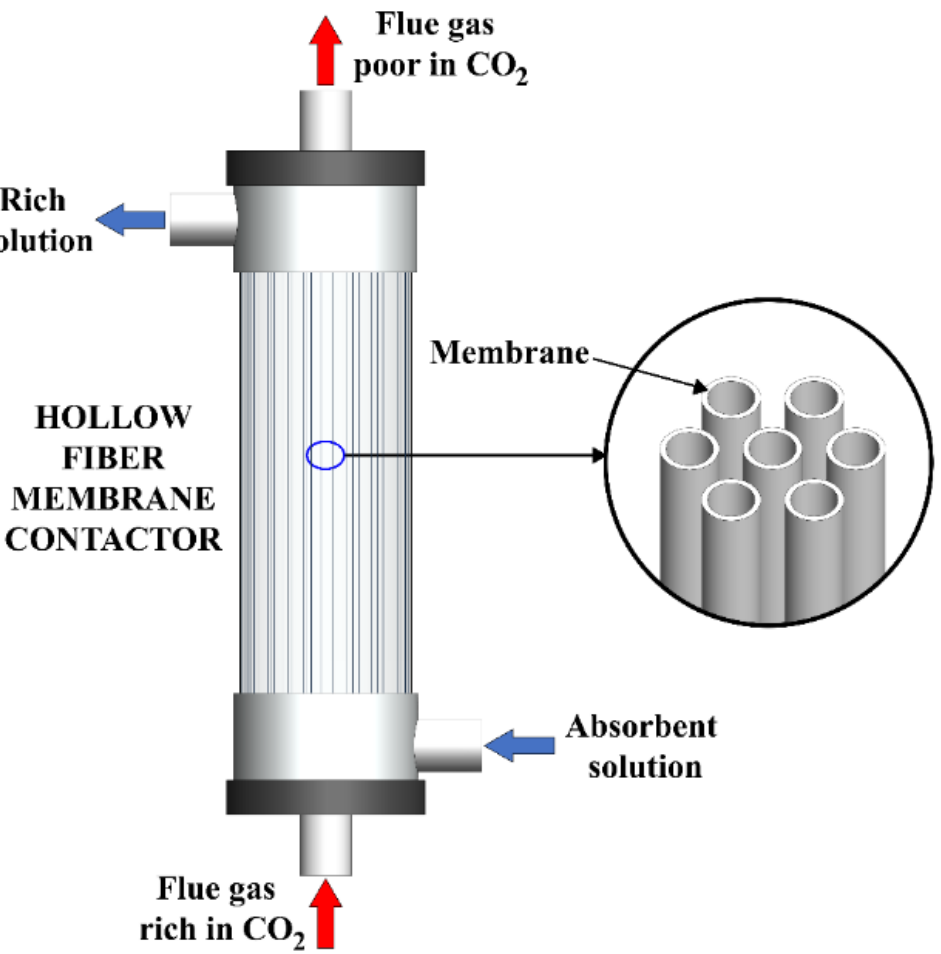
Figure 2. Schematic representation of the hollow-fiber membrane contactor for CO 2 absorption process [25].